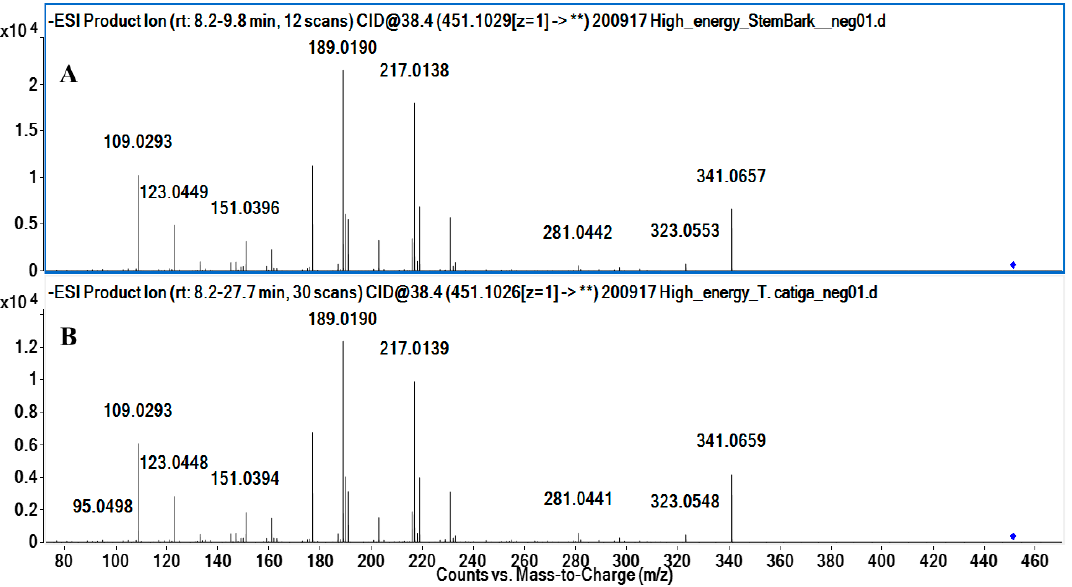
Figure 5. MS 2 spectra of [M − H] − = 451.1029 for cinchonain Ib ( 33 ) from the stem bark of A. uleanus ( A ) and crude extract of T. catigua ( B ) at the same collision energy.